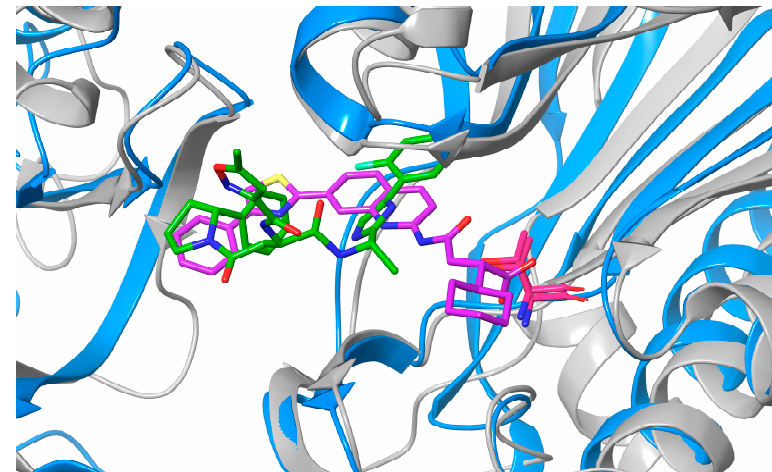
Figure 3. Superimposition of the β 5i subunit of human IP (blue, PDB code 5M2B) and Mtb proteasome β subunit (grey, PDB code 6ODE) showing high similarity between the two enzymes and their active sites. The respective ligands Ro19 (purple) and B6 (green) are also presented. Catalytic threonine residues (Thr1) are red.